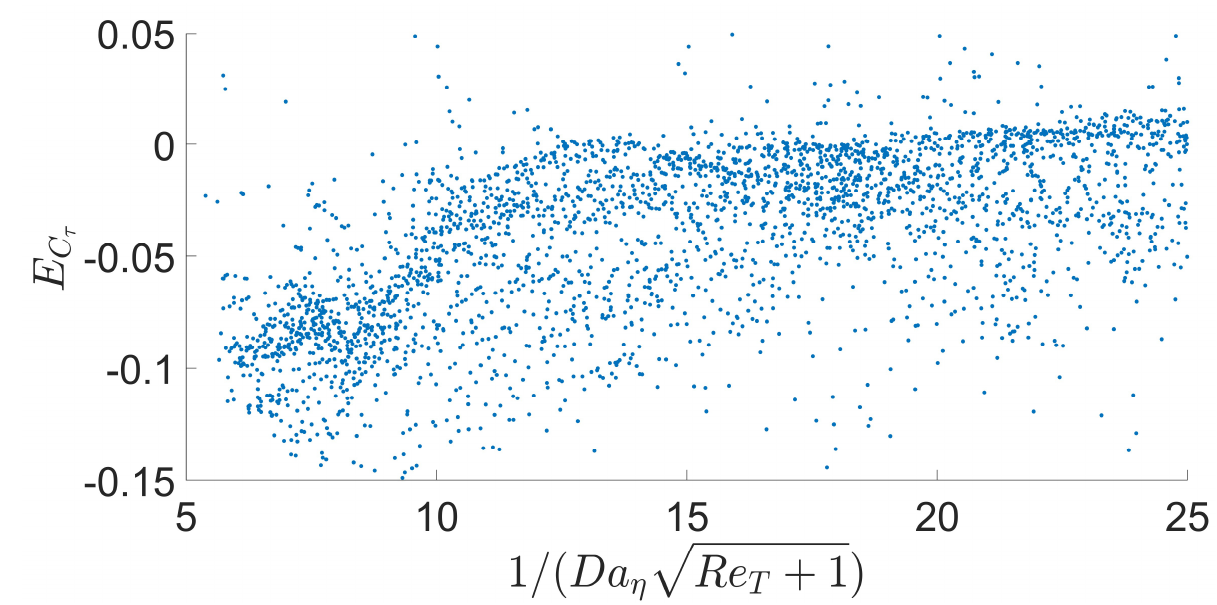
√ (cid:0) (cid:1) Da η Re T + 1 (cid:3086) (cid:3493)𝑅𝑒 (cid:3021) + 1(cid:3439) . Figure 8. Model sensitivity to C τ as a function of 1/